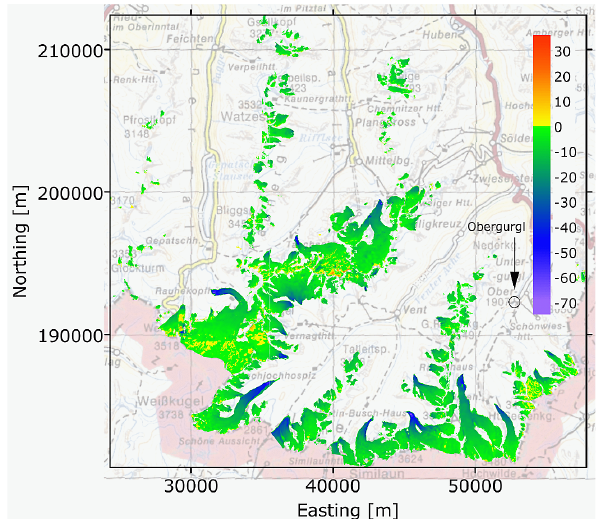
Fig. 4. Ice thickness variation (m) within the ¨Otztal Alps during the period between 1997 and 2006 derived from glacier inventories (Abermann et al., 2009). The small circle indicates the location of the gravity station in Obergurgl. Coordinates refer to the Gauss– Kr¨uger coordinate system with central meridian 10 ◦ 20 0 E (northing coordinate reduced by 5 × 10 6 )